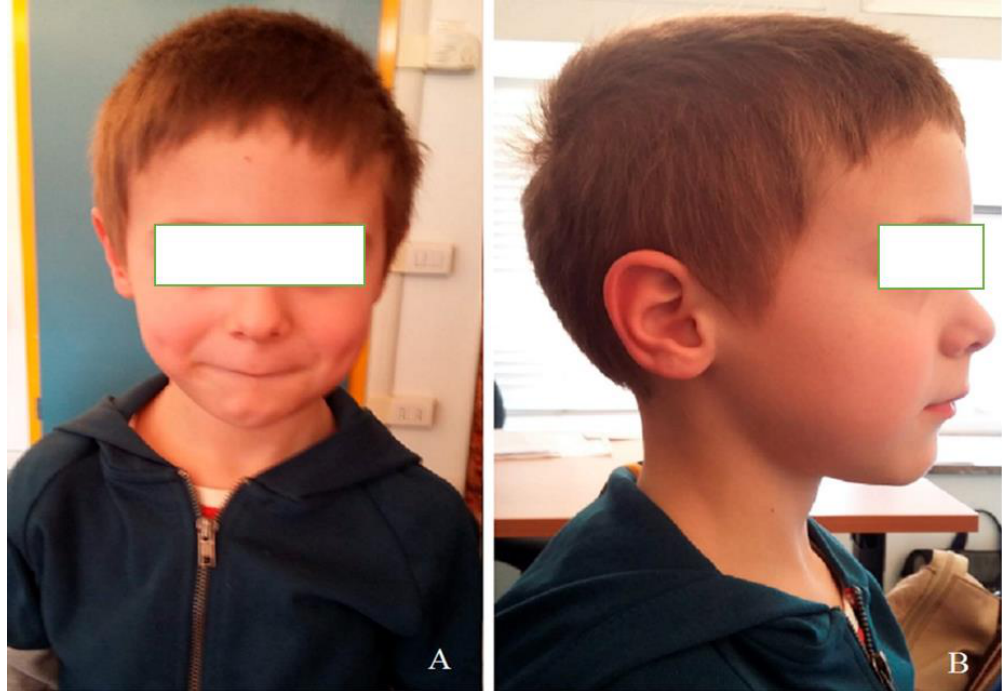
Figure 1. ( A , B ) Facial images of the patient at 5 years of age do not show any specific dysmorphisms.